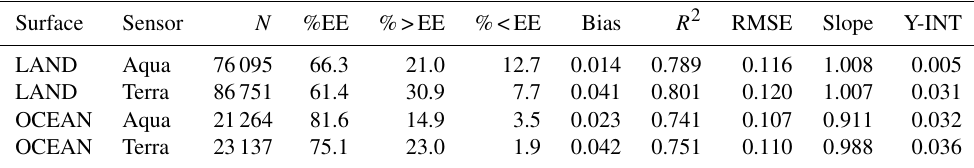
Table 1. Summary of scatterplots (not shown) of collocated MODIS and AERONET measurements of AOD at 0.55µm, showing the per- formance of MYD04 (Aqua) and MOD04 (Terra) products relative to AERONET sun photometer data. Reported variables include N as the number of collocations, and %EE, %>EE and %<EE as percentages of collocations falling within, above and below EE envelopes. Bias is average difference (MODIS–AERONET), and slope, Y-INT, R 2 are parameters of least-squares linear regression. Surface Sensor N %EE %>EE %<EE Bias R 2 RMSE Slope Y-INT LAND Aqua 76095